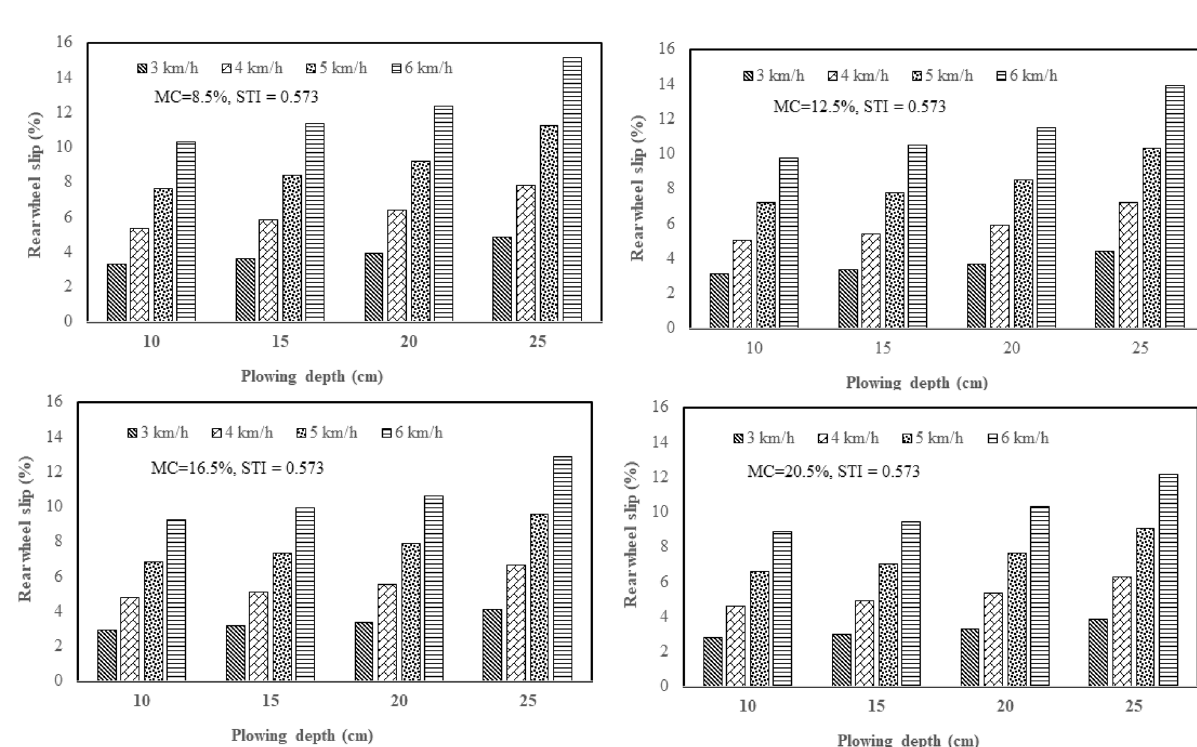
Figure 6. Effect of plowing speed and depth on the tractor rear wheel slip in 2WD mode at different levels of soil moisture content during plowing process by chisel plow in soil with a texture index of